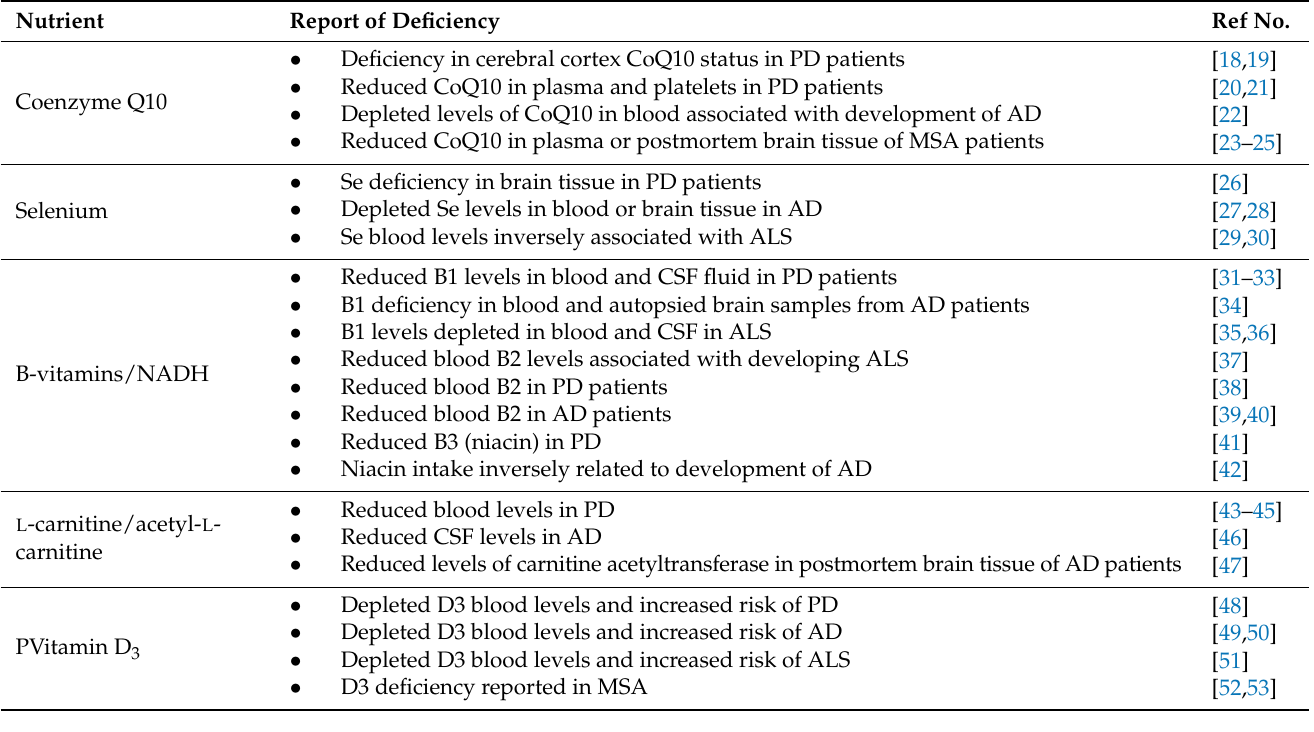
Table 1. Nutritional deficiencies in neurodegenerative disorders.